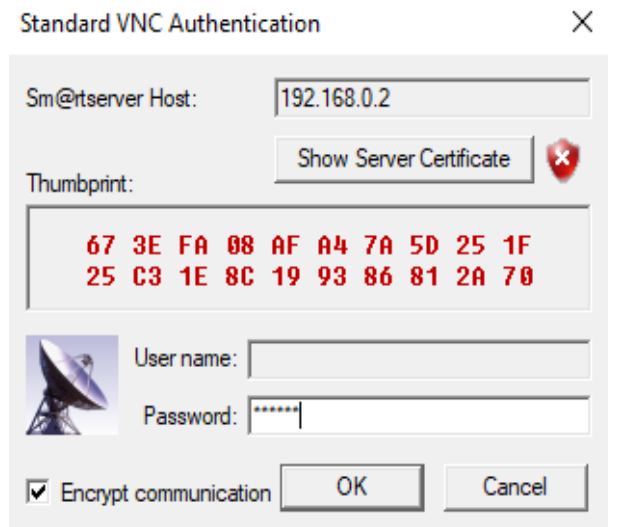
Figure 17. Enter password.